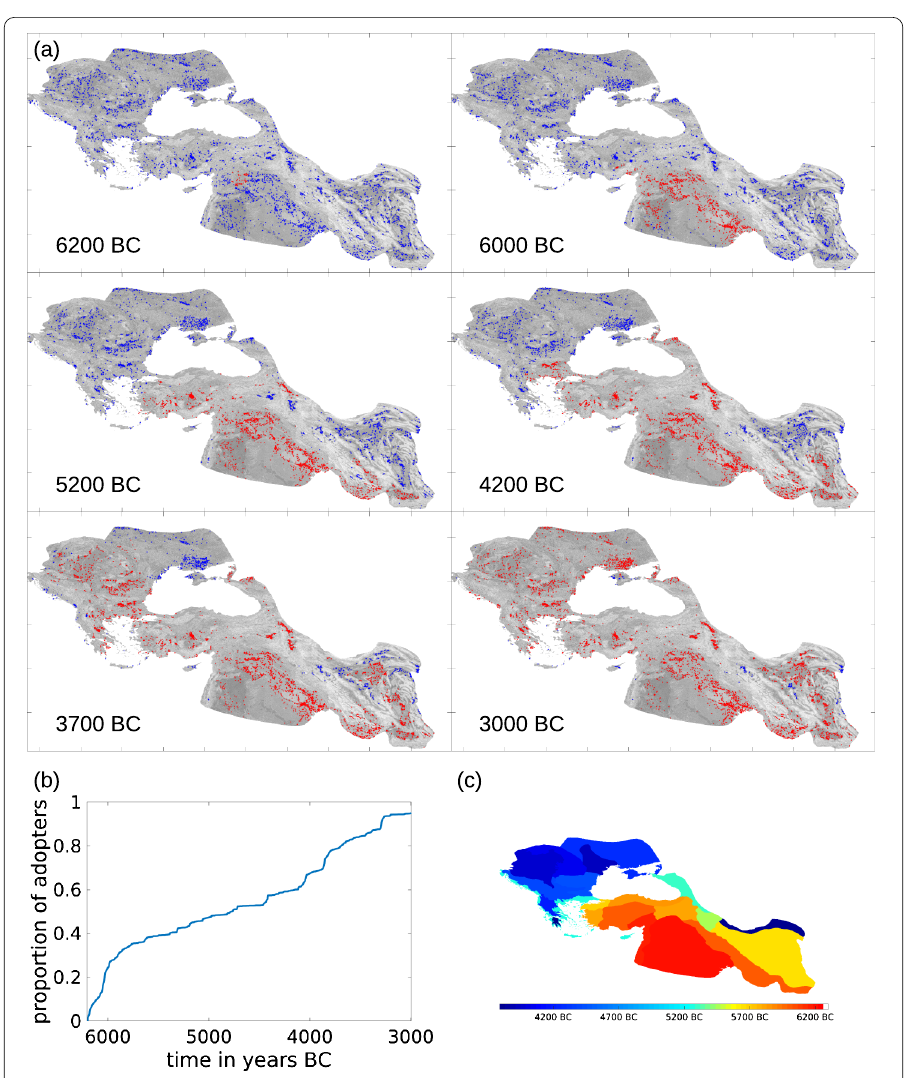
Figure 6 ( a ) Snapshot of one realization of the wool-bearing sheep innovation spreading, where blue dots indicate agents that have not adopted the innovation and red dots give agents that have adopted the innovation. ( b ) Proportion of adopters over time, indicating metastability of the innovation process is presented. ( c ) The first hitting times of the 23 landscape regions for the example